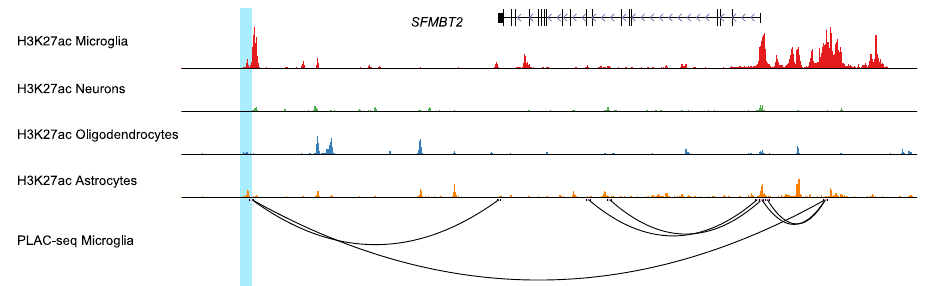
Fig. 4 | The brain-speci fi c genomic context of cg14511218 and relation to SFMBT2 . The fi gureshowschromosome10,position6,000,000 – 7,600,000(b37), with the location of cg14511218 highlighted. Data from Nott et al. 34 show histone acetylation associated with active enhancers and promoters (H3K27ac) across